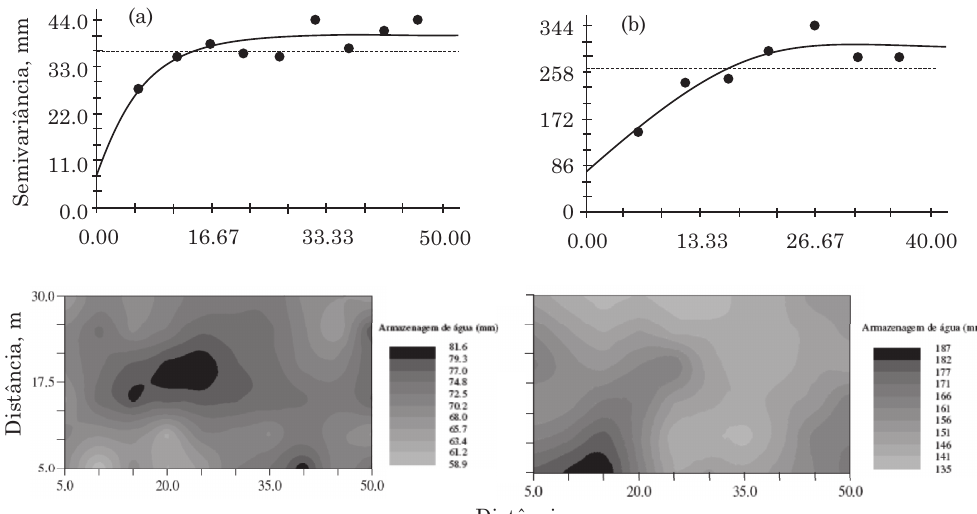
Figura 7. Semivariograma e mapa da armazenagem de água no solo nas camadas de 0-0,40 m (a) e 0-0,80 m (b) durante o ciclo da aveia-preta. Semivariogramas escolhidos de acordo com os parâmetros da validação cruzada. Períodos 4 e 5 para as camadas de 0,0-0,40 e 0,0-0,80 m,